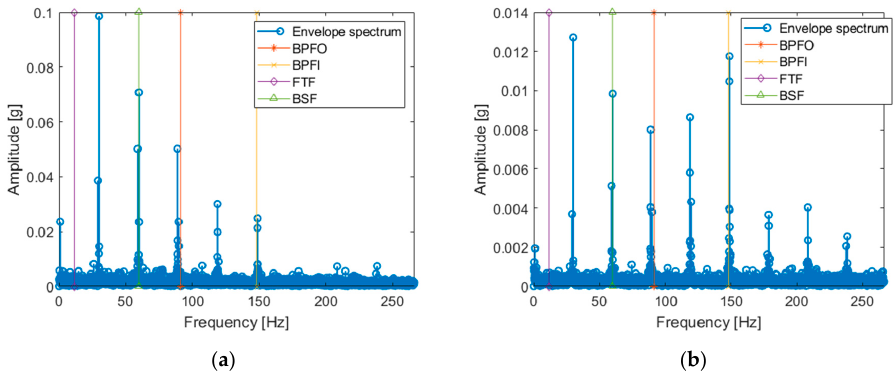
Figure 18. Envelope spectrum reflecting the raw and AR filtered signals: ( a ) envelope spectrum of the raw signal, and ( b ) envelope spectrum after AR filter.